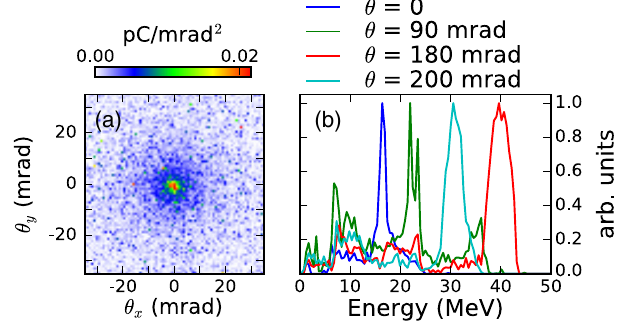
FIG. 11. Results from the PIC simulation at normal incidence. (a) Angular distribution of the electrons with an energy greater than 1 MeVaround the specular direction. (b) Energy spectrum of the electrons such that θ < 10 mrad (dark blue curve), 85 mrad < θ < 95 mrad (green curve), 175 mrad < θ < 185 mrad (red curve), and 195 mrad < θ < 205 mrad (light blue curve), where θ is the angle with respect to the specular direction. In this plot, a value of 1 on the y axis corresponds to 0 . 46 pC = MeV for the dark blue curve, 0 . 34 pC = MeV for the green curve, and 0 . 74 pC = MeV for the red and light blue